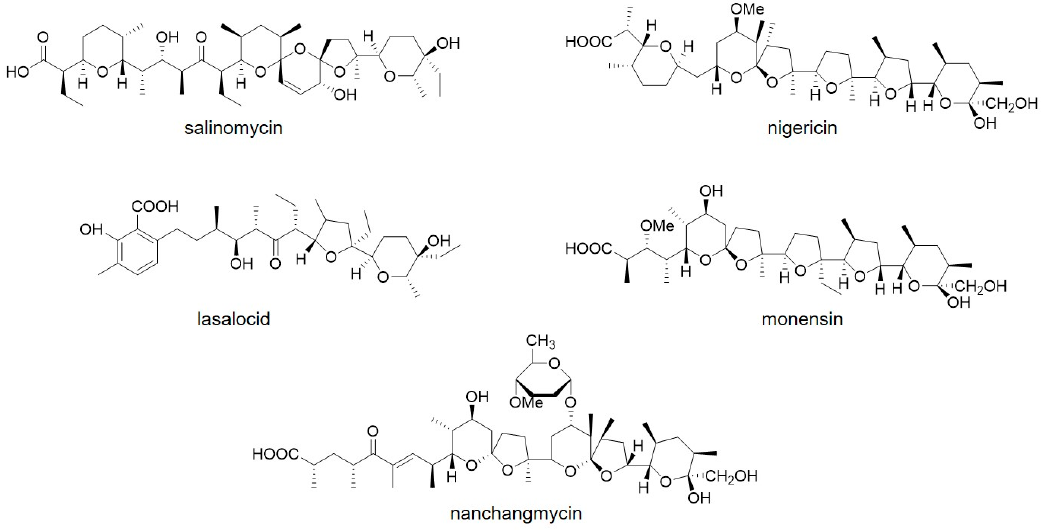
Figure 1. Structures of polyether antibiotics.